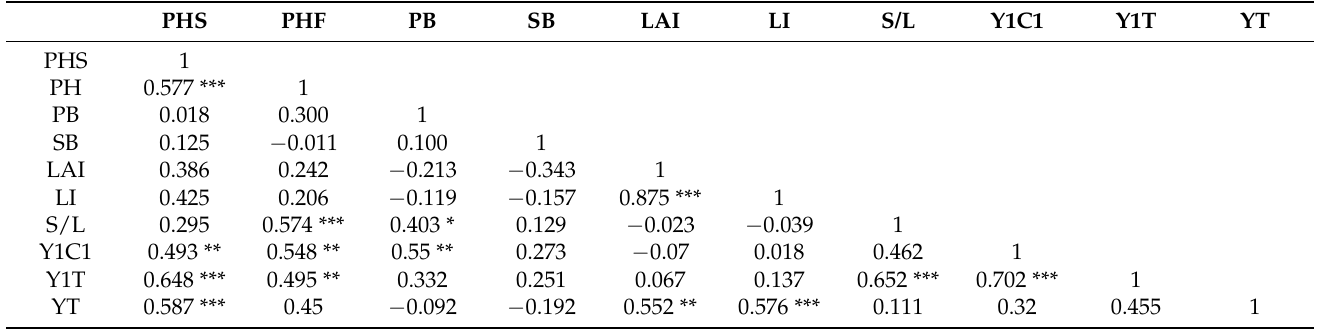
Table 2. Correlation coefficient matrix among morphological traits of 10 alfalfa